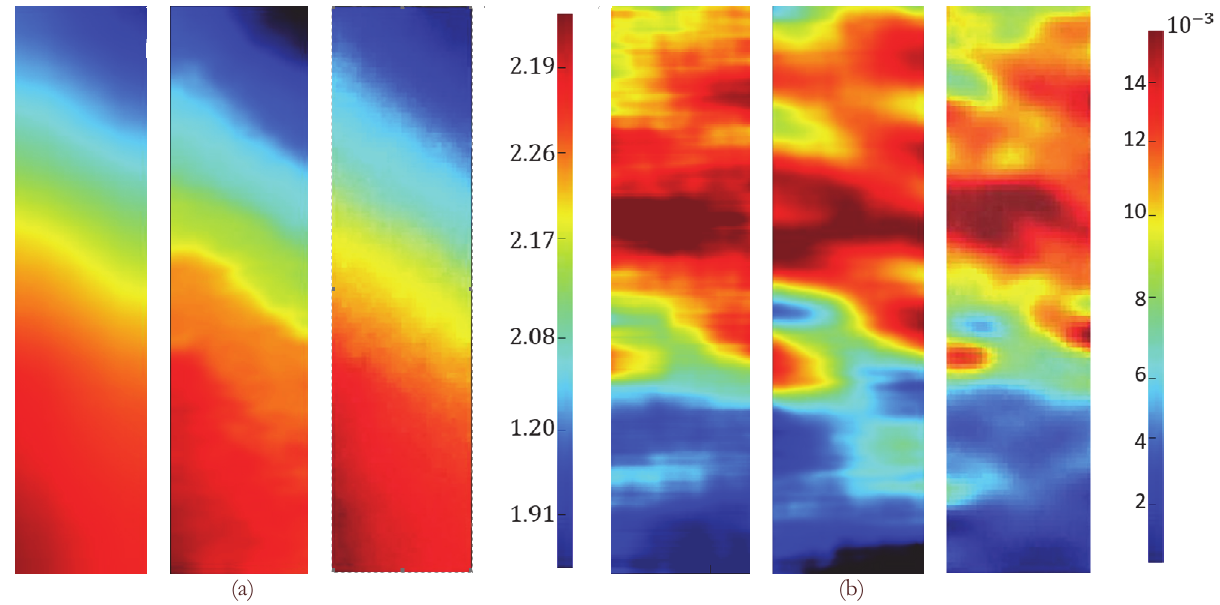
Figure 2: Asphalt mixture sample 1: results computed, in order of appearance, with LSM, SGM, NCORR. (a) Map of the displacement along X axis [mm]; (b) Map of the strain along X axis [-].